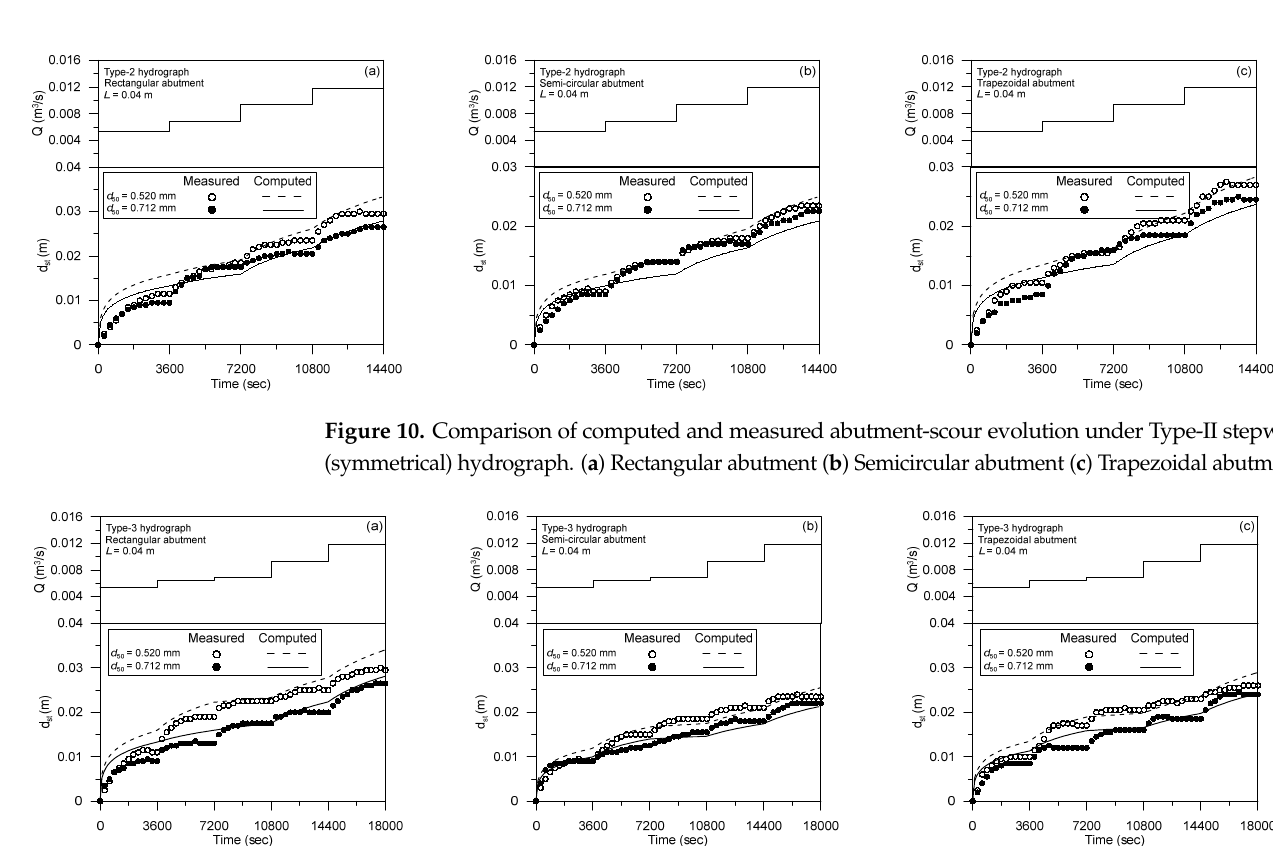
Figure 9. Comparison of computed and measured abutment-scour evolution under Type-I stepwise (advanced) hydrograph. ( a ) Rectangular abutment ( b ) Semicircular abutment ( c ) Trapezoidal abut- ment.